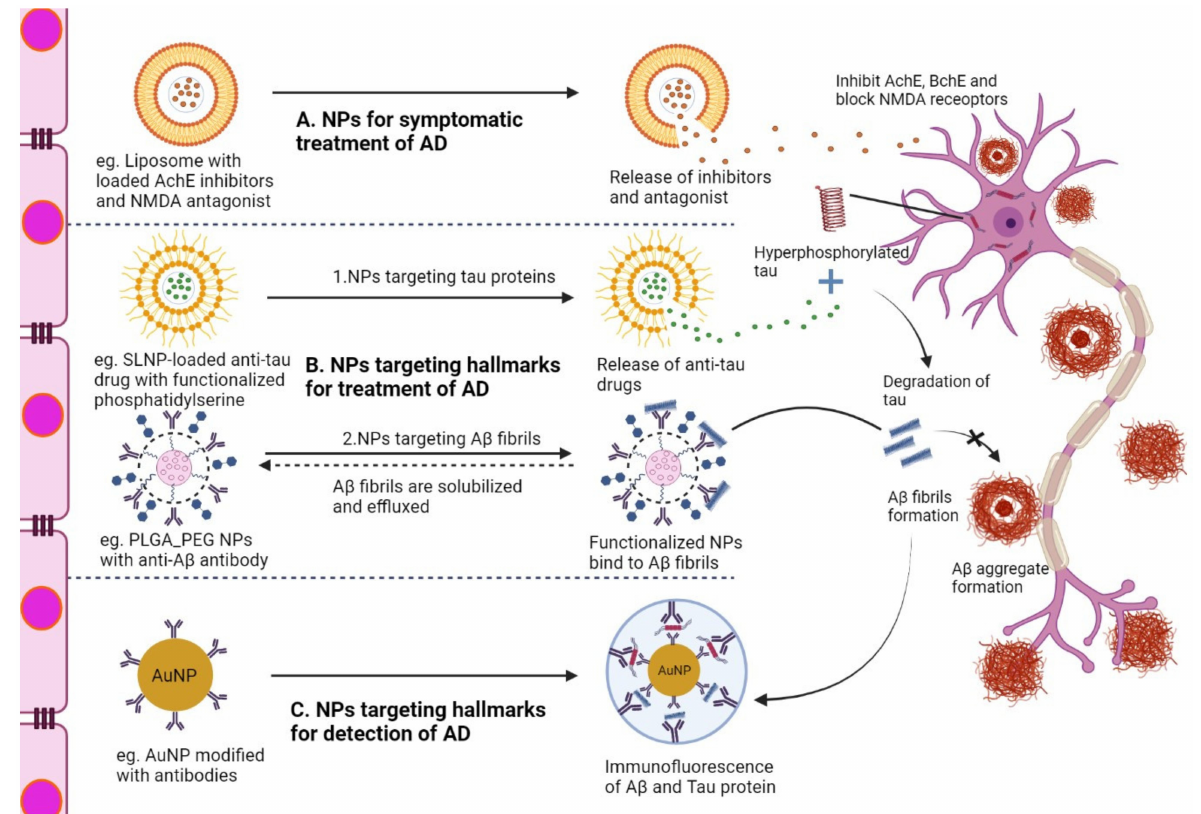
Figure 2. Illustration of the action mechanism of NPs in neurons associated with AD after overcoming the BBB. ( A ) Liposome with loaded AchE inhibitors targeting cholinergic system impairment, ( B ) 1. SLNP-loaded anti-tau drug with functionalized phosphatidylserine targeting hyper-phosphorylated tau proteins, ( B ) 2. PLGA-PEG with anti-A β antibody is involved in targeting, solubilizing, and clearing A β fibrils, ( C ) Modified AuNP with capture antibody targeting A β and tau proteins, making a sandwich with secondary antibody for diagnosing hallmarks associated with AD. AchE, acetyl- cholinesterase; NMDA, N-methyl D-aspartate antagonist; A β , amyloid beta fragment, PEG, polyethy- lene glycol; SLNP, solid lipid nanoparticle, NP, nanoparticle; PLGA, poly D,L-lactic-co-glycolic acid; AuNP, gold